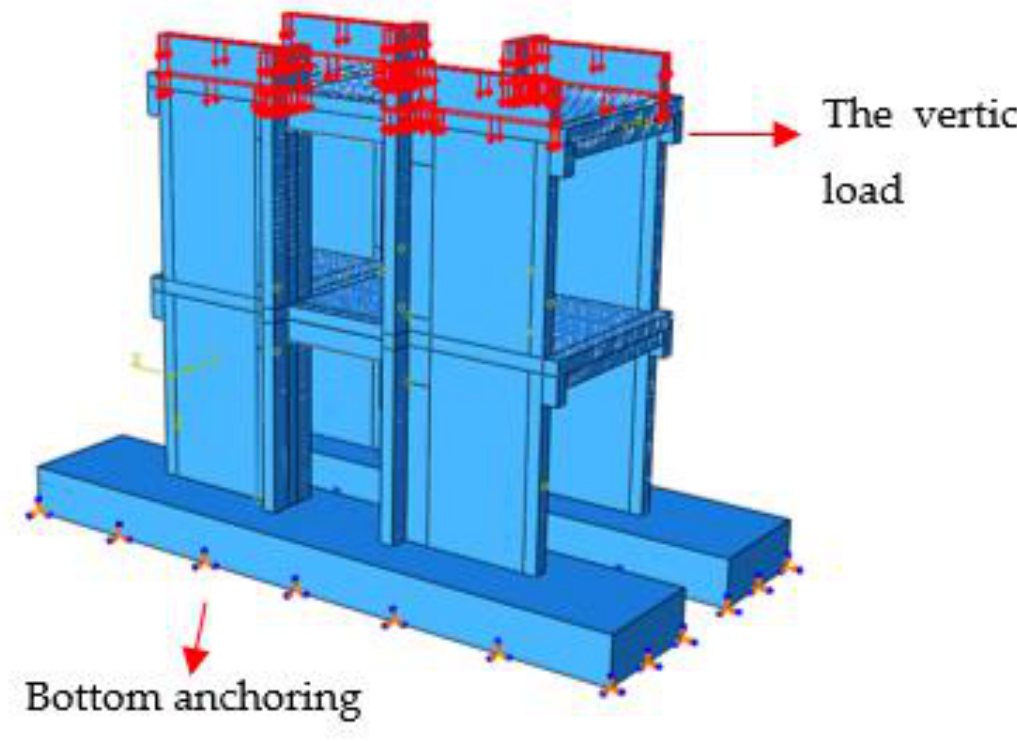
Figure 3. Boundary conditions and vertical loads.